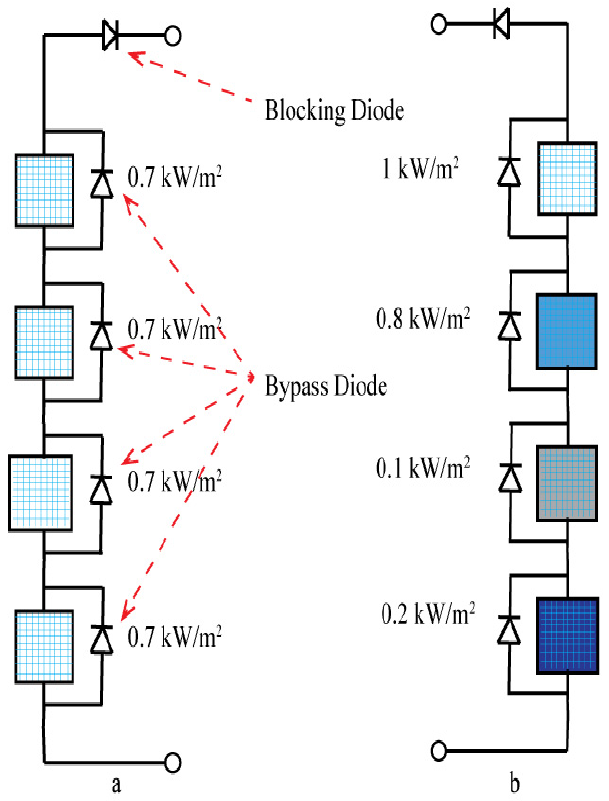
Figure 3. ( a ) Uniform Irradiance Case ( b ) Partial Shading